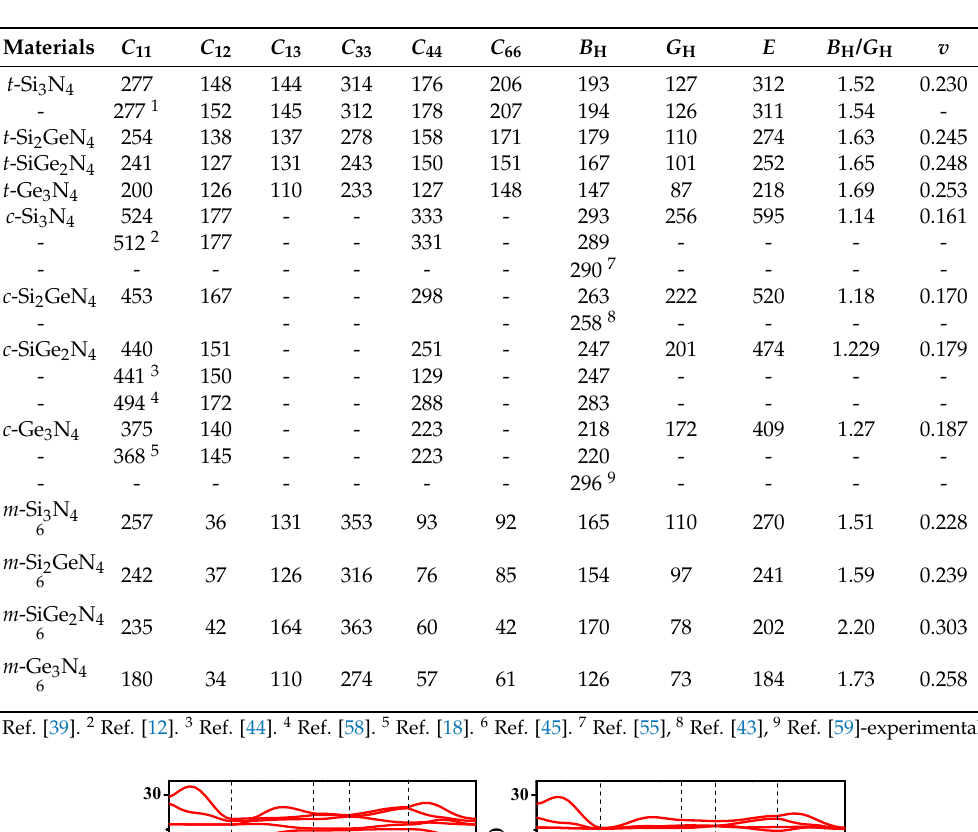
2 GeN 4 ( a ) and t -SiGe 2 N 4 ( b